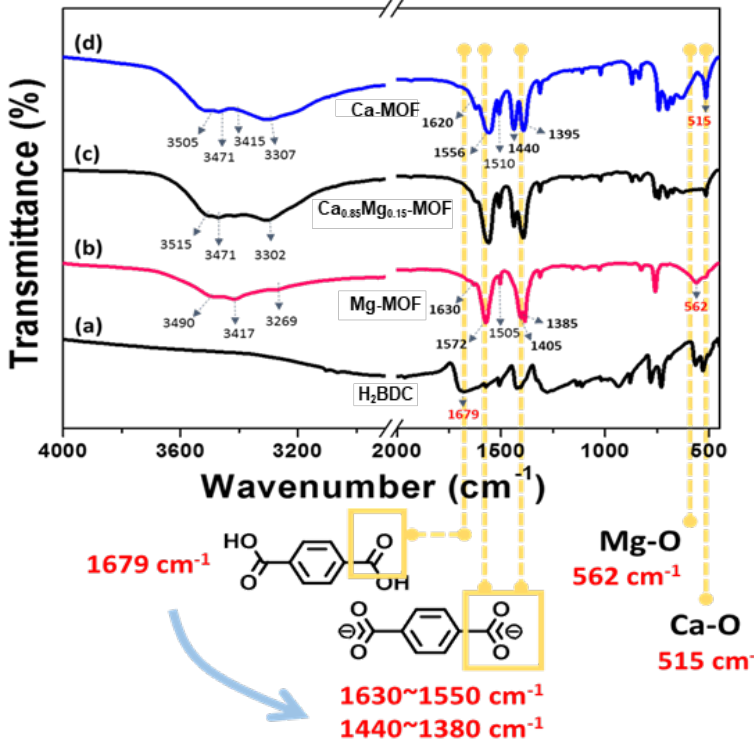
Figure 2. Fourier transform infrared (FTIR) spectra were used to analyze the adsorption peaks of ( a ) H 2 BDC, ( b ) Mg-MOF, ( c ) Ca 0.85 Mg 0.15 -MOF, and ( d ) Ca-MOF where the peaks at 562 cm −1 and 515 cm −1 can be assigned to Mg-O bond and the Ca-O bond, respectively, to indicate the formation of Mg-MOF and Ca-MOF.